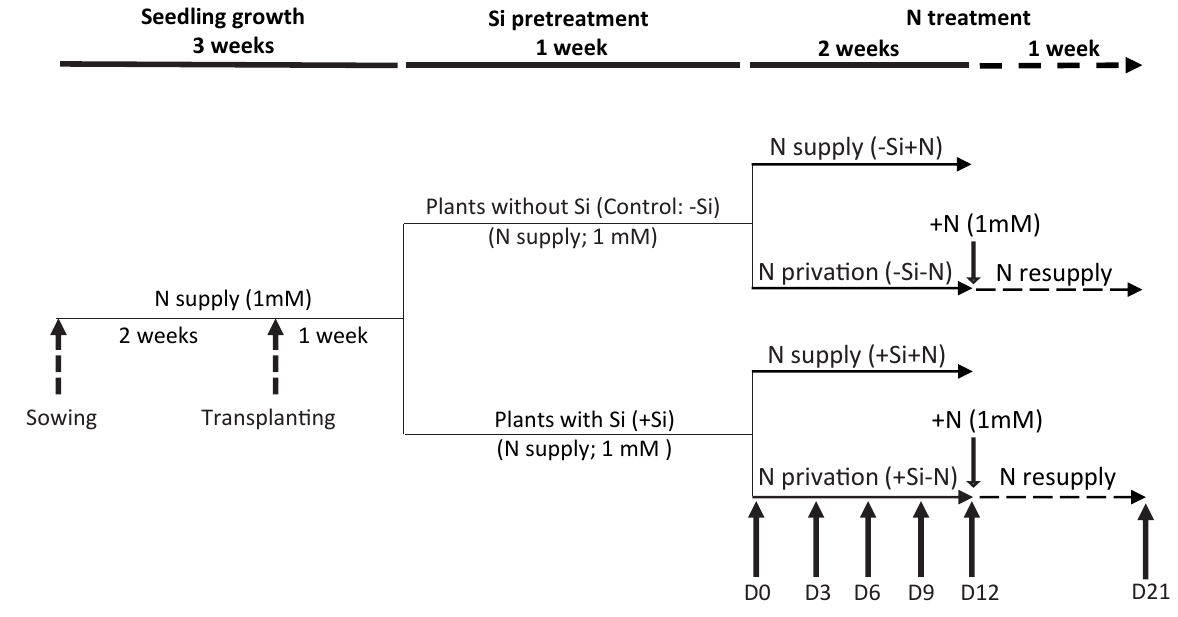
FIGURE 1 | Experimental design used to study the effect of silicon pretreatment on growth parameters of Brassica napus L. cultivated with or without nitrogen for 12 days and then resupplied with N (from Day 12 to 21). After a period of pretreatment for 1 week with (+Si: 1.7 mM Na 2 SiO 3 ) or without silicon (control: –Si), plants were separated into two groups: the first was supplied with 1 mM of NH 4 NO 3 (–Si+N and +Si+N) and the second was N deprived (–Si–N and +Si–N). Day 0 (D0) corresponds to the end of the Si pretreatment and the beginning of the N treatment. After 12 days (D12), N-deprived plants were resupplied with 1 mM of NH 4 NO 3 until 21 days after the end of the Si pretreatment (D21). Plants were harvested after 0, 3, 6, 9, 12, and 21 days for N-deprived plants (dashed